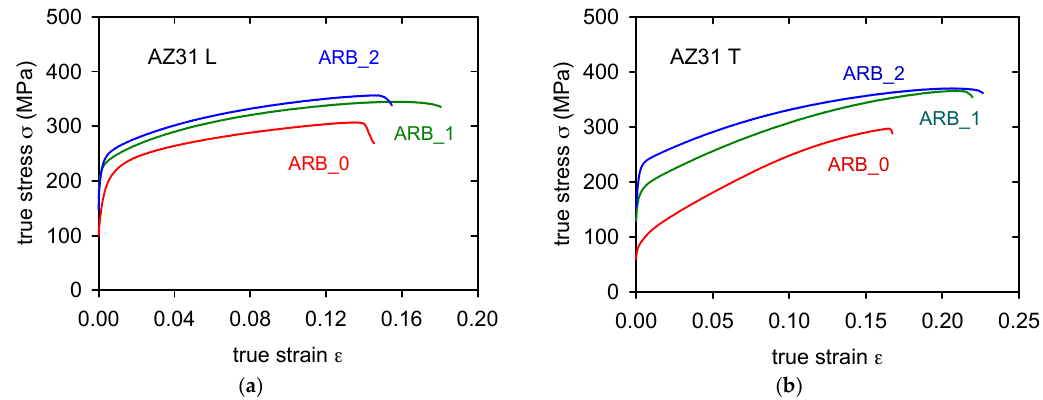
Figure 10. True stress—true strain curves obtained at room temperature for various numbers of passes: ( a ) L-samples, ( b ) T-samples. Table 2. Strain to fracture, ε f , estimated for both samples orientations and temperatures. Material L-orientation T-orientation